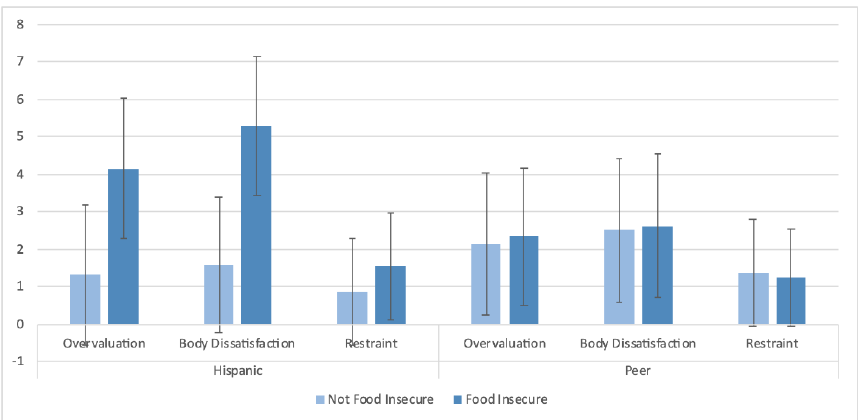
Figure 3. Eating disorder psychopathology in Hispanic versus peer adolescents. In the model including overvaluation/body dissatisfaction, food insecurity, and ethnicity, p interactions were significant (for overvaluation, p interaction = 0.017; for body dissatisfaction, p interaction < 0.01). Among Hispanic adolescents: for overvaluation, p < 0.01; for body dissatisfaction, p < 0.01; for restraint, p = 0.88. Among peer adolescents: for overvaluation, p = 0.65; for body dissatisfaction, p = 0.85; for restraint, p = 0.67. Mean ± SD are displayed.